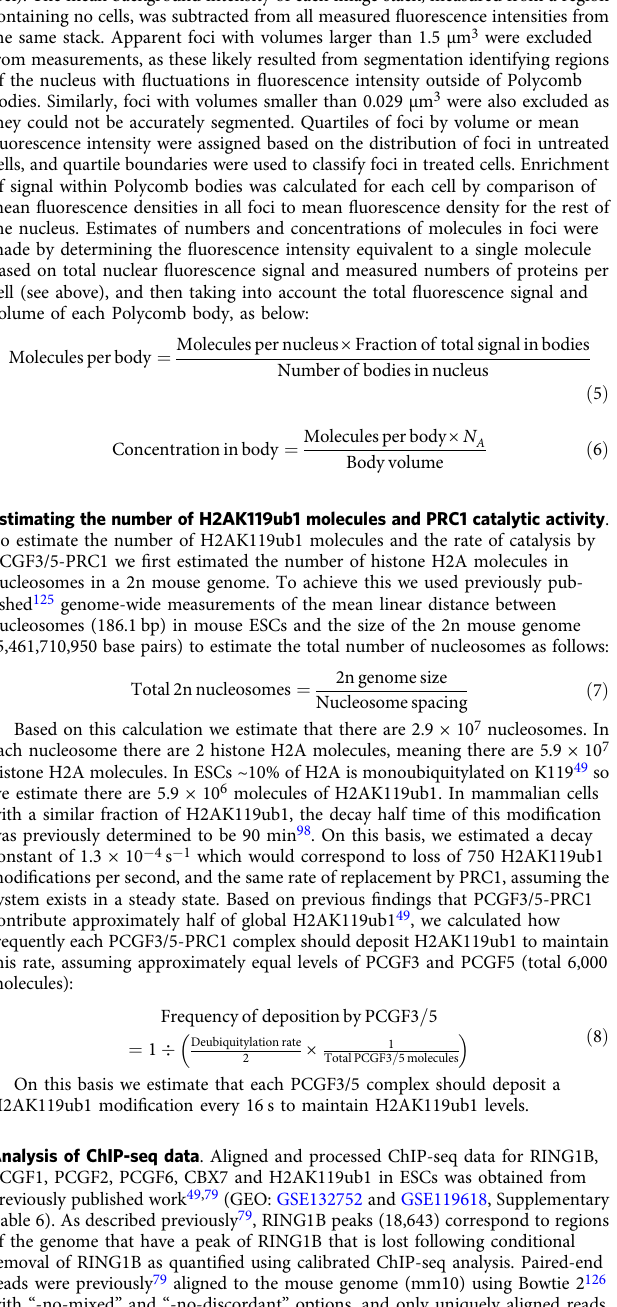
Calculation of target search time . Target search times for PCGF3 were calculated as described previously 62,75 using the equation below: N bound ¼ t bound ð 4 Þ N bound þ N free t bound þ t search where N bound is the number of molecules in the bound state of interest and t bound is the mean time spent in this bound state. N bound was calculated for each bound state by multiplying the total number of molecules by the fraction of observed binding events belonging to that state and the fraction of all molecules that were bound. For PCGF3, because short binding events (1.5s) predominate, and stable binding events are rare, signi fi cantly longer, and therefore highly infrequent (<4% of PCGF3 molecules, t bound = 39s, t search > 1000 s), only the short binding time was taken into account when calculating t search in the context of catalysis. FRAP analysis . To measure fl uorescence recovery, intensity measurements were made with Fiji and ImageJ 123 . Fluorescence intensity was measured in the bleached region and a corresponding unbleached region within the same cell. From each, the intensity of a background region outside of cells was subtracted. The relative intensity of bleached and unbleached regions was calculated by dividing background-corrected unbleached intensity by background-corrected bleached intensity. Prebleach measurements were used to normalise all values so that the mean of the relative prebleach intensity was 1. The mean, normalised relative intensity of all repeats was plotted with error bars indicating standard error of the mean. Polycomb body analysis . To segment Polycomb bodies in individual live cells for analysis, nuclei were fi rst manually segmented in 3D based on Hoechst fl uores- cence in the 405nm channel using TANGO in ImageJ 124 . The 561 nm channels of the same Z-stacks were deconvolved using Olympus cellSens software (constrained iterative deconvolution, 5 cycles). Deconvolved 561nm z-stacks were masked